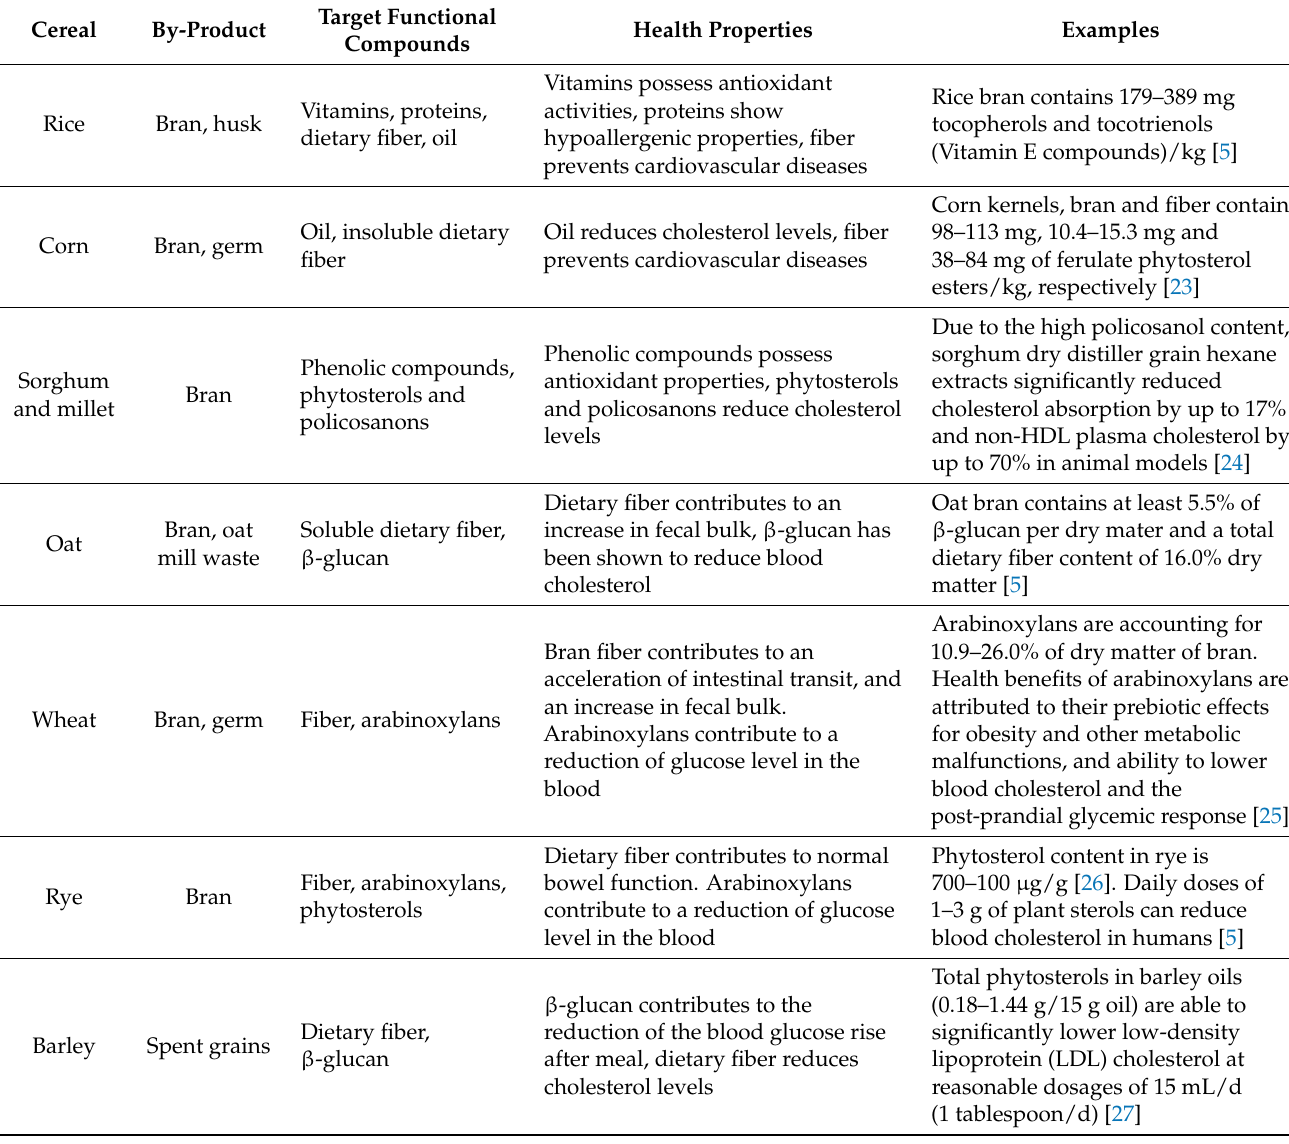
Table 2. Functional components of cereal processing by-products and health properties (remade from